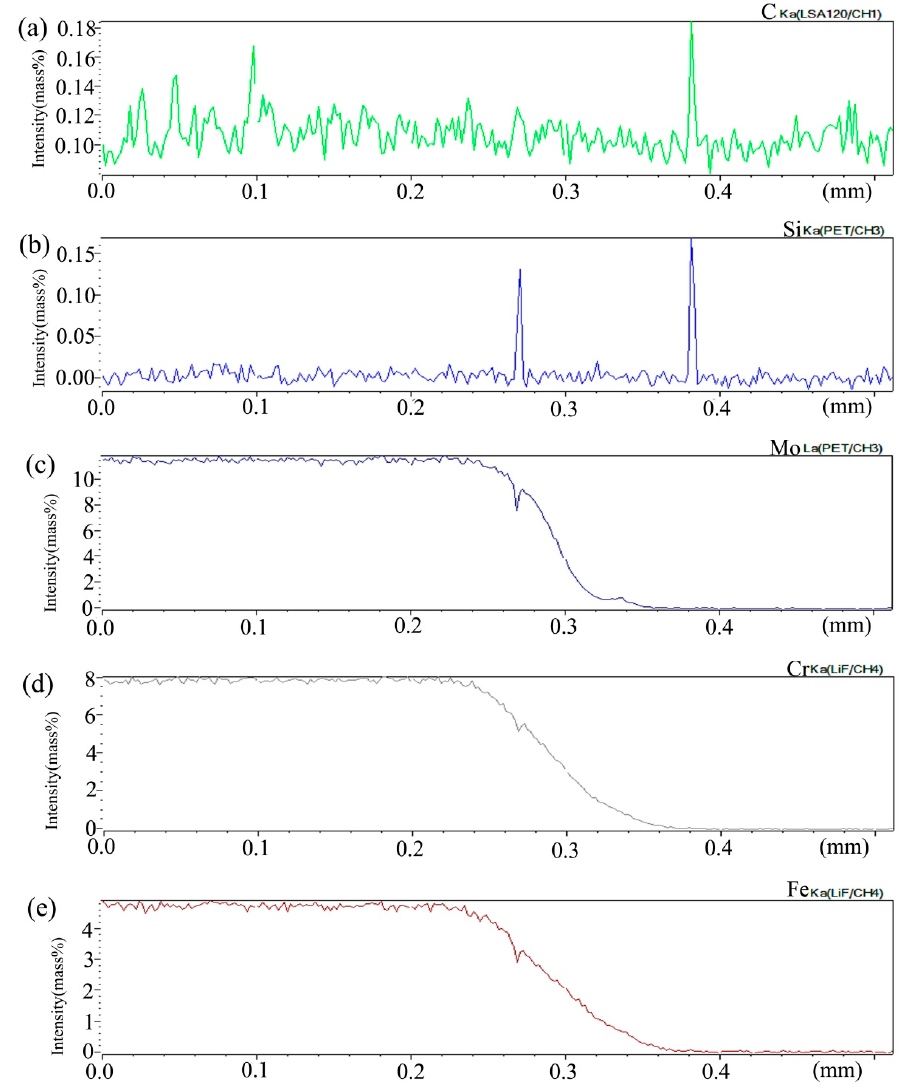
Figure 12. Composition distribution curve of the diffusion couple sample of 0Si alloy and pure nickel after 1000 °C/200 h heat treatment: ( a ) C, ( b ) Si, ( c ) Mo, ( d ) Cr, and ( e ) Fe. (The horizontal coordinate